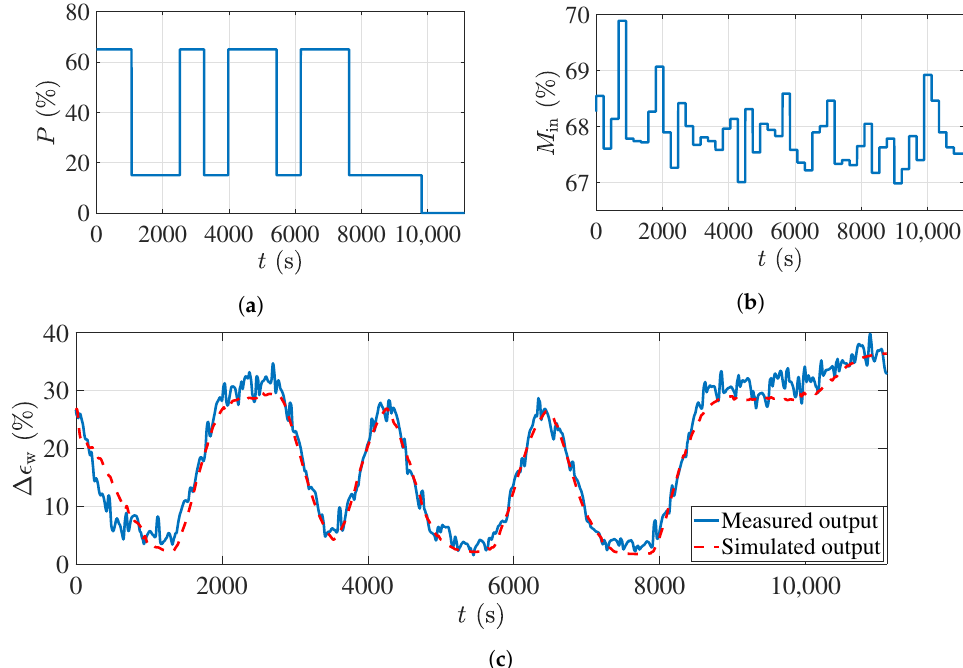
Figure 8. The input–output dataset with the PRBS input signal used for estimating the process model: ( a ) The applied input power percentage to the microwave sources. ( b ) The input foam moisture variations. ( c ) Comparison between the actual measurements and the model